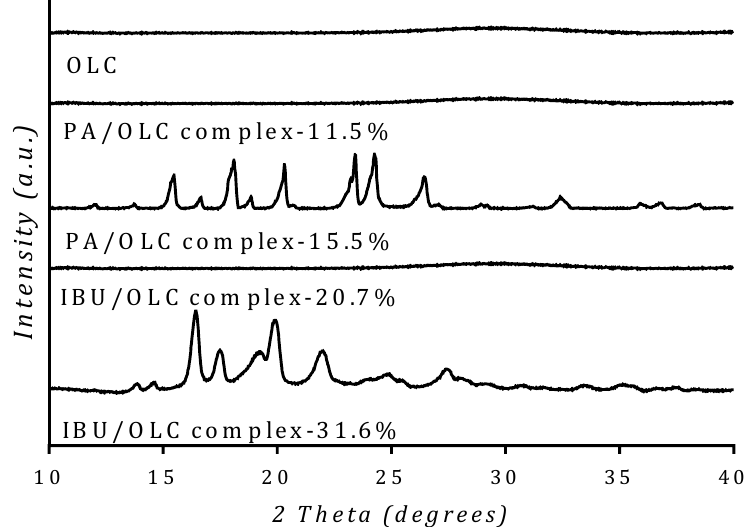
Figure 5. XRD patterns of carbon onion (OLC) paracetamol-loaded carbon onion (PA/OLC complex) and ibuprofen-loaded carbon onion (IBU/OLC complex) with different drug